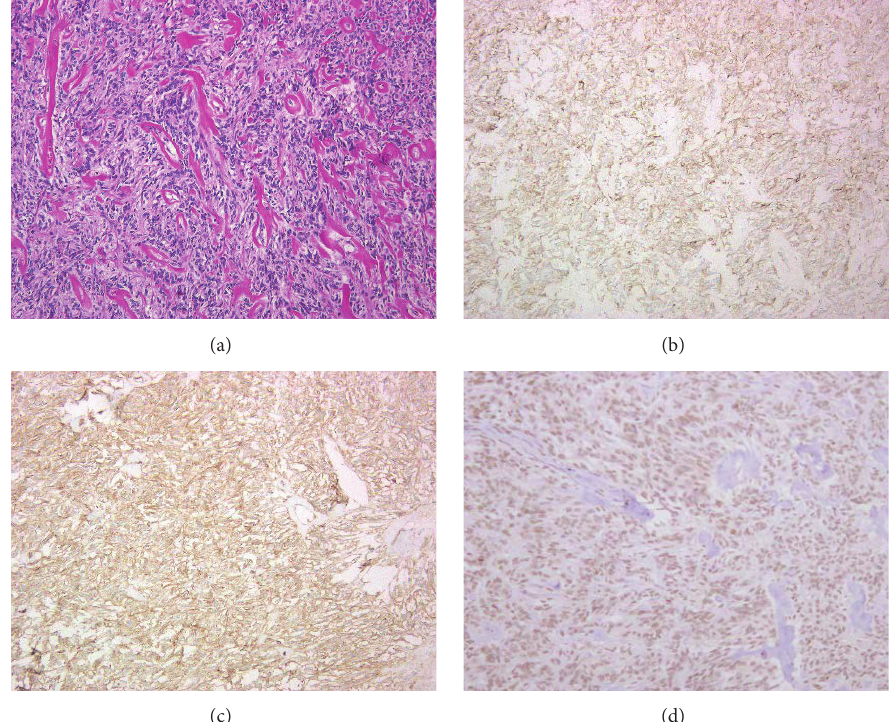
Figure 5: Microscopic finding of resected prostatic tumor. (a) HE staining; (b) AE1/AE3; (c) CD34; (d) STAT6 (original magnification ×